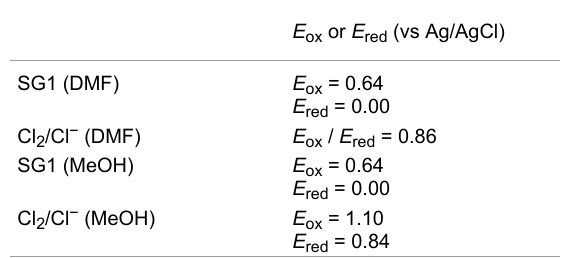
Table 1: Experimental redox potential of the oxidation ( E ox ) and of the reduction ( E red ) in DMF and MeOH. a